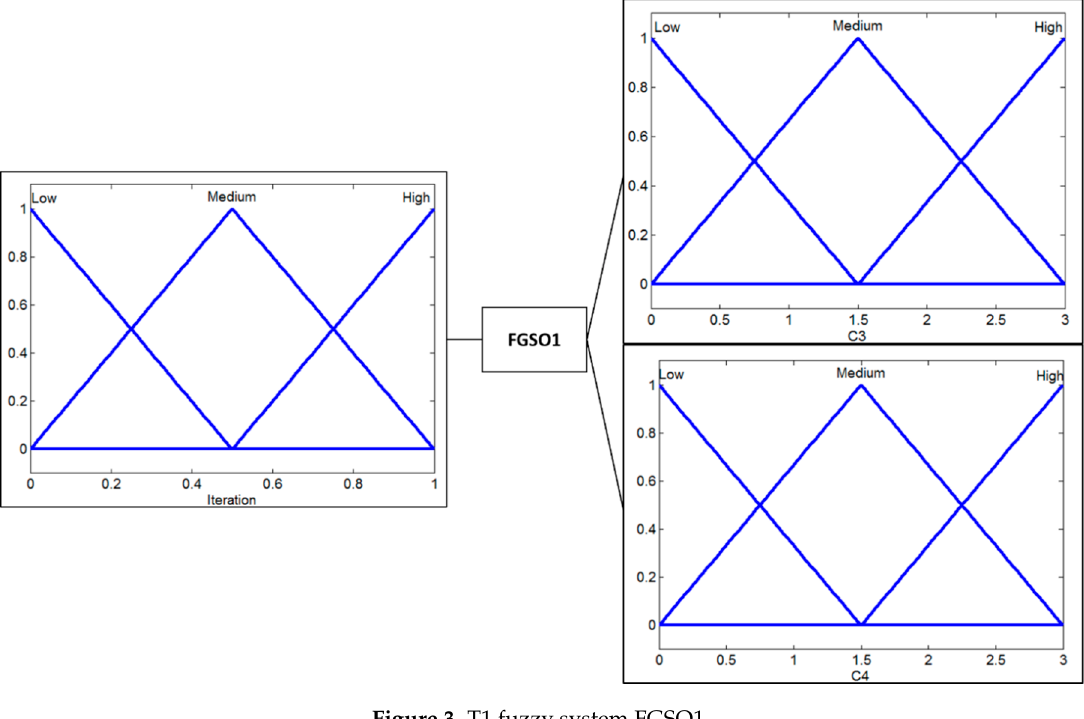
Figure 3. T1 fuzzy system FGSO1.